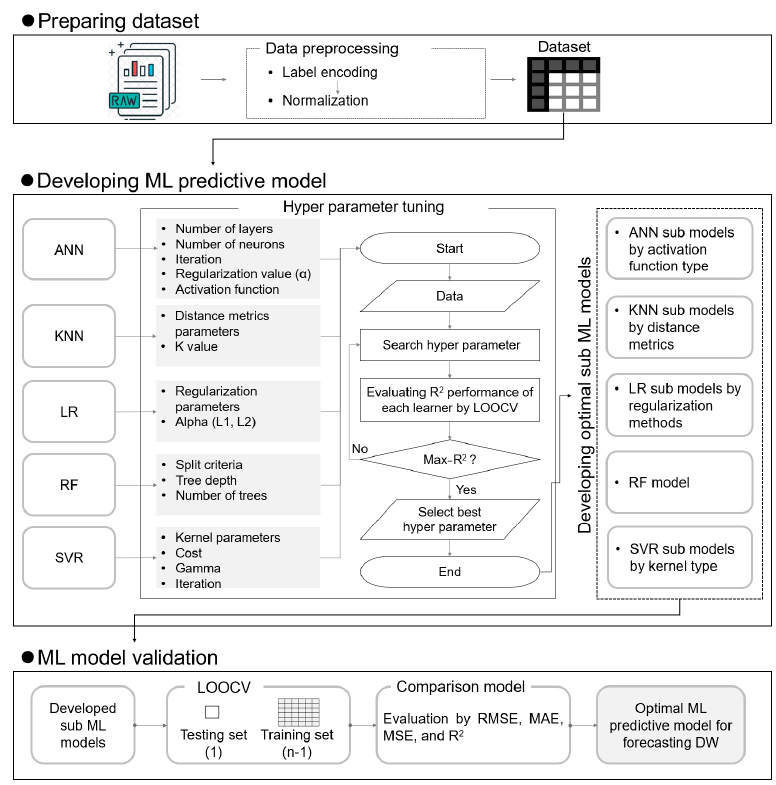
Figure 1. Research flow for development of DWGR prediction model.